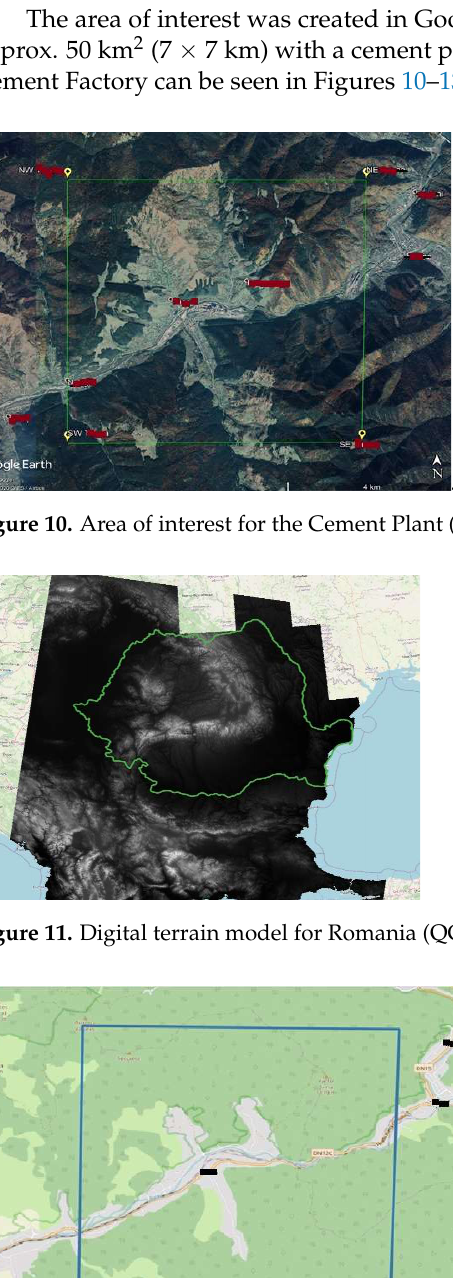
Figure 13. Digital terrain model in the module: left) AERMAP; right) 3D Analyst